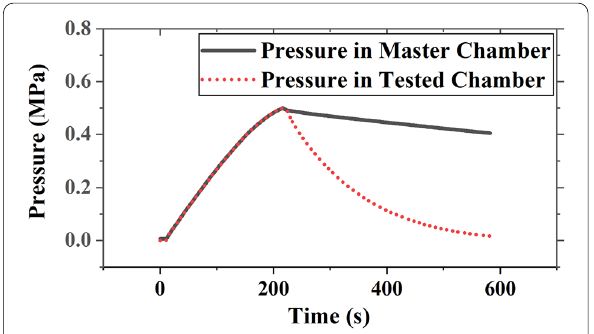
Figure 8 Pressure variation of two chambers with